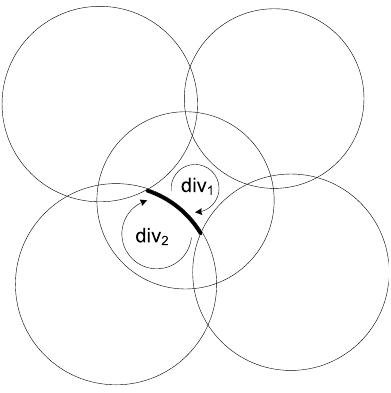
Figure 2. An example of Algorithm